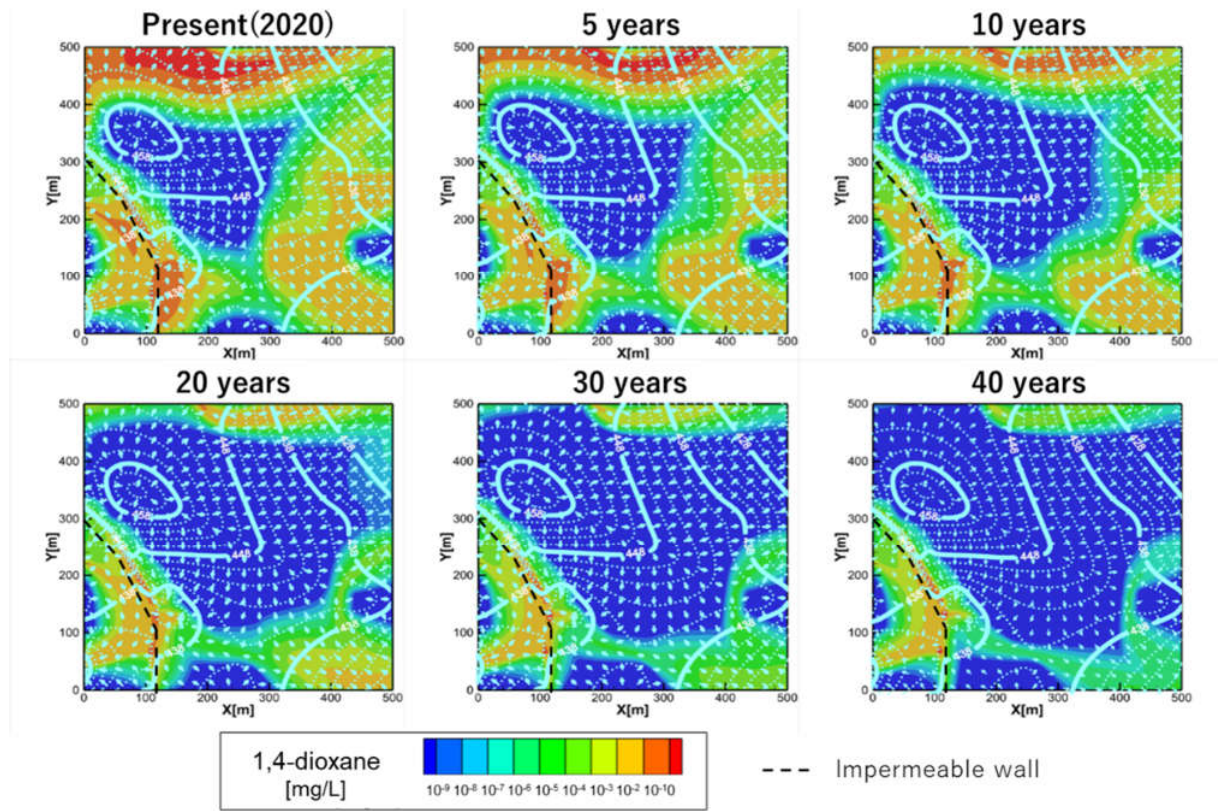
Figure 4. 1,4-Dioxane concentrations in groundwater by passive treatment over time. Contour lines indicate groundwater levels and vectors indicate flow directions. The color of the legend indicates the concentration of 1,4-dioxane.